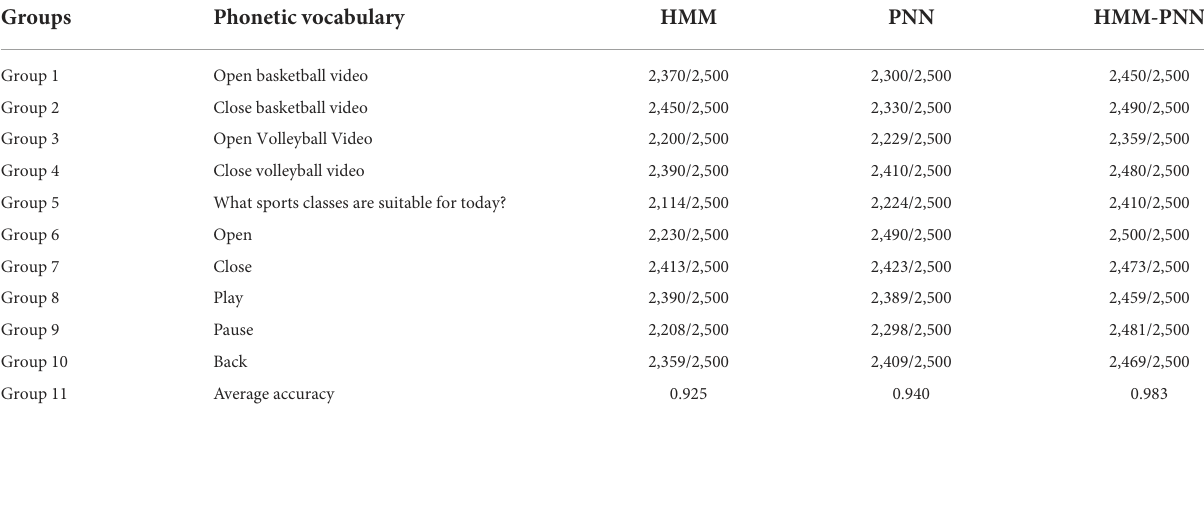
TABLE 1 Speech recognition accuracy